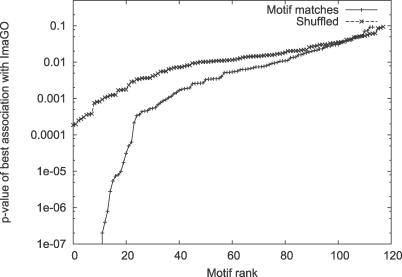
Significance of Correlation between Motifs and ImaGO Terms, in Rank OrderThe “shuffled” trace gives an indication of the likely false discovery rate at a given p-value significance threshold.